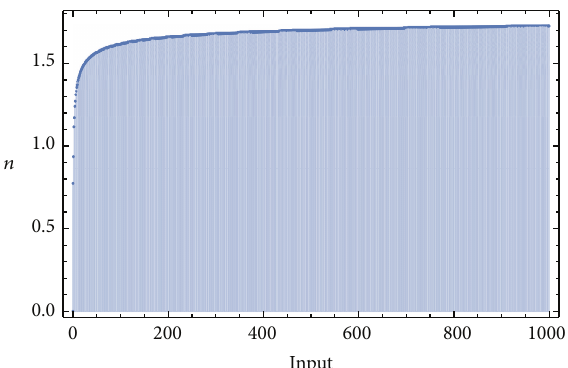
Figure 2: The figure shows an estimate of the box dimension of 2,2 TMwithTMnumber346.Onthehorizontalaxis,theinputisshown and the vertical axis shows the corresponding approximation of the box dimension. Note that we know that the function converges to 2 when the input tends to infinity.